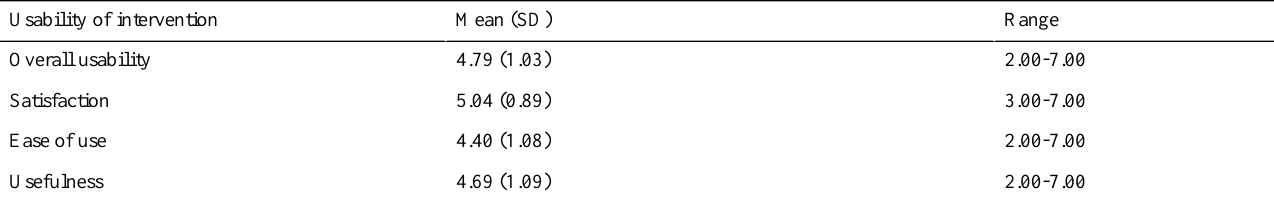
Table 2. Participant-reported usability of hospital-community-family intervention (average scores; possible range=1-7; higher scores indicate greater overall usability, higher degree of satisfaction, easier use, and better effectiveness of the hospital-community-family